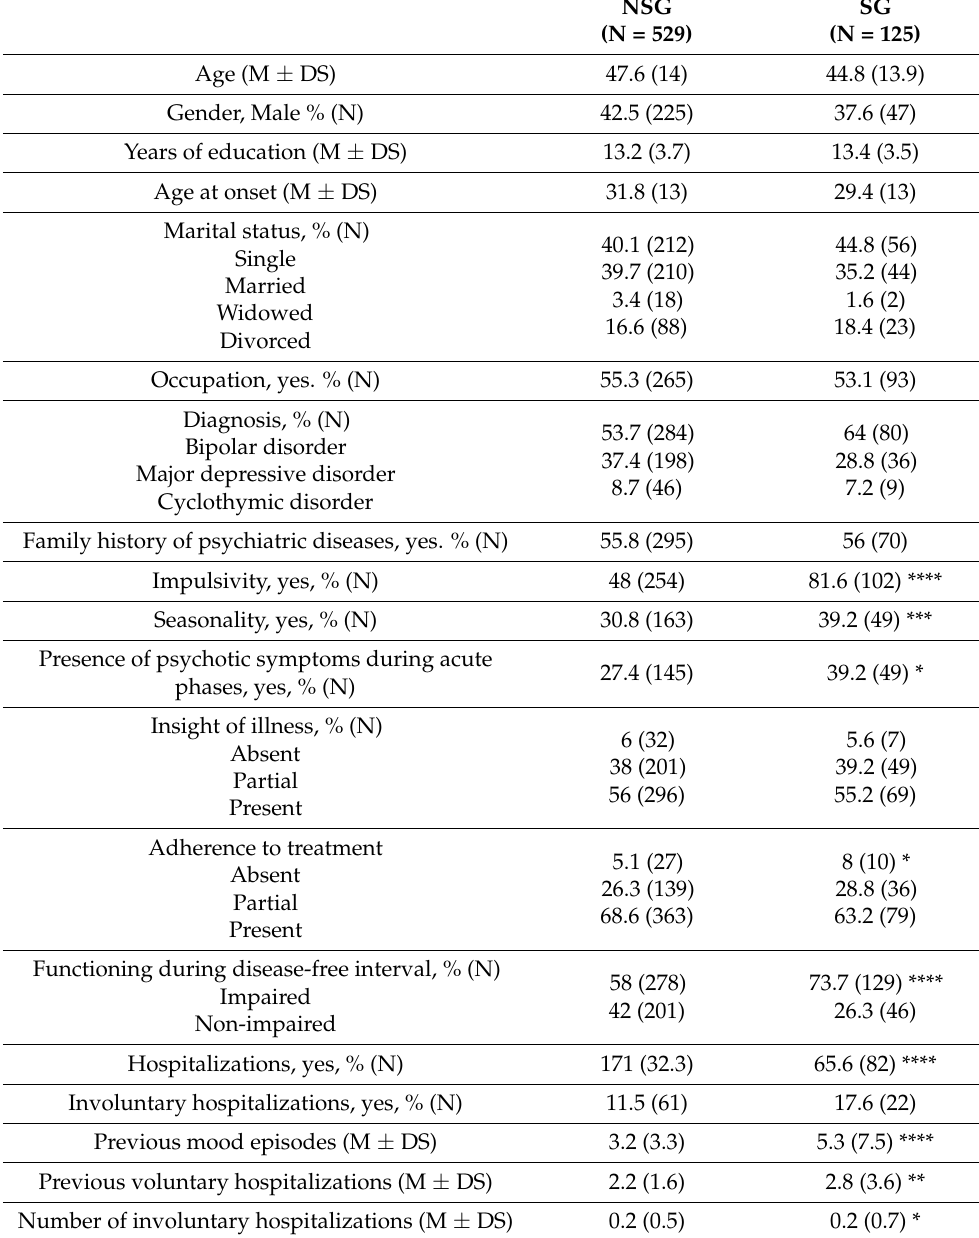
Table 1. Differences in sociodemographic and clinical characteristics among patients with and without suicide